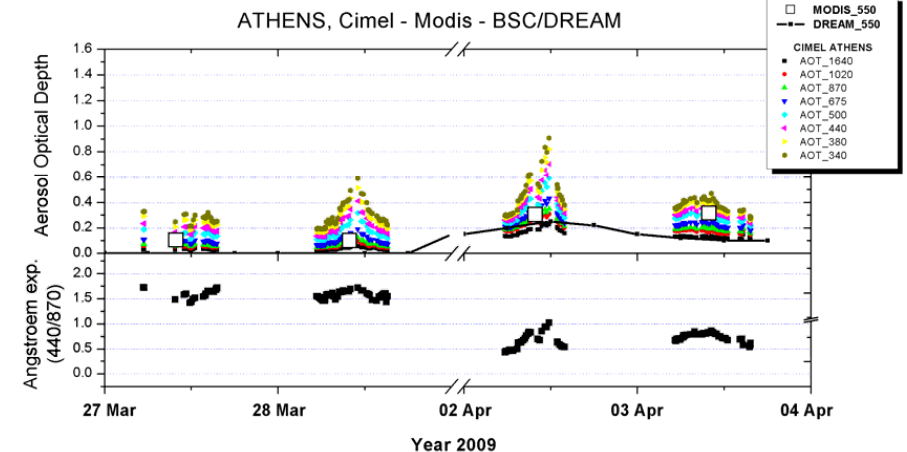
Fig. 6. Temporal evolution of the AOD at eight wavelengths over Athens for the period 27 March to 4 April 2009 according to CIMEL sun- sky radiometer, MODIS at 550nm (white squares) and BSC-DREAM model at 550nm (upper panel). Temporal evolution of the ˚Angstr¨om exponent (440/870nm) for the same time period (lower